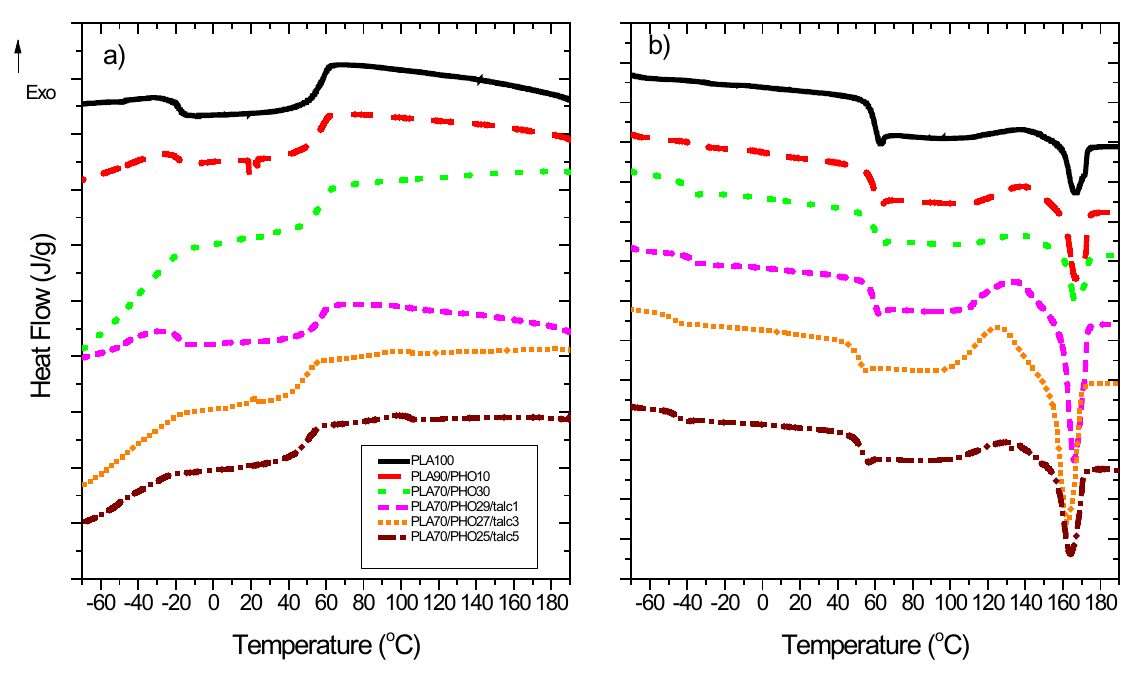
Figure 1: DSC curves of PLA and its samples at a rate 20°C/min. a) cooling and b) 2 nd